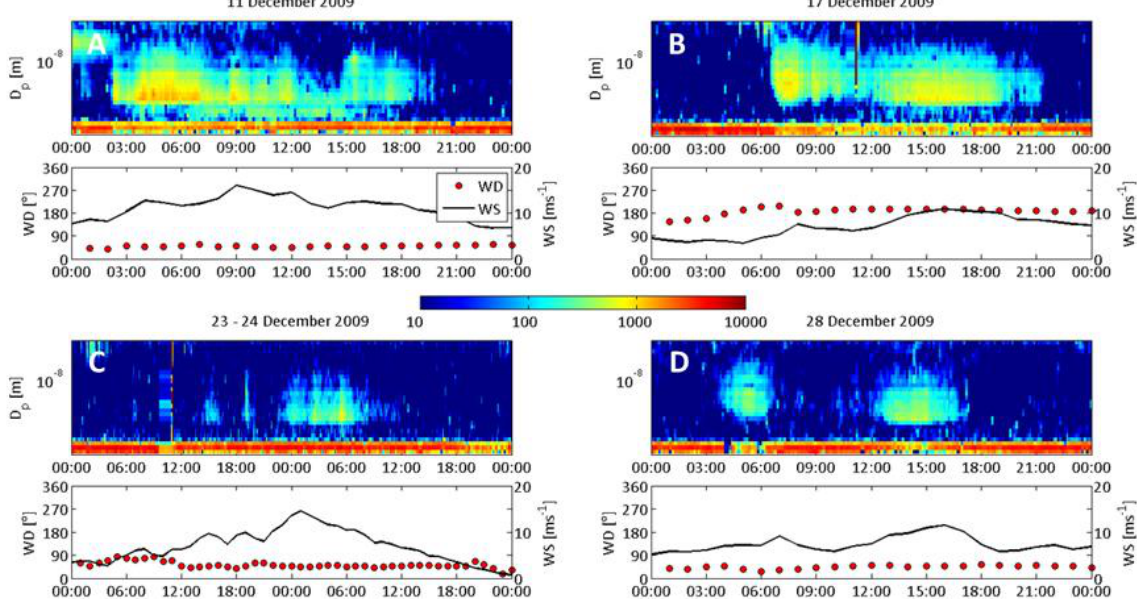
Fig. 6. Wind-induced events during December 2009. Boxes (A–D) show the particle size distribution from AIS (negative polarity) as well as wind direction and speed during five days of wind-induced events on December 2009. The colour scale in AIS surface plots is dN/dlog D p .